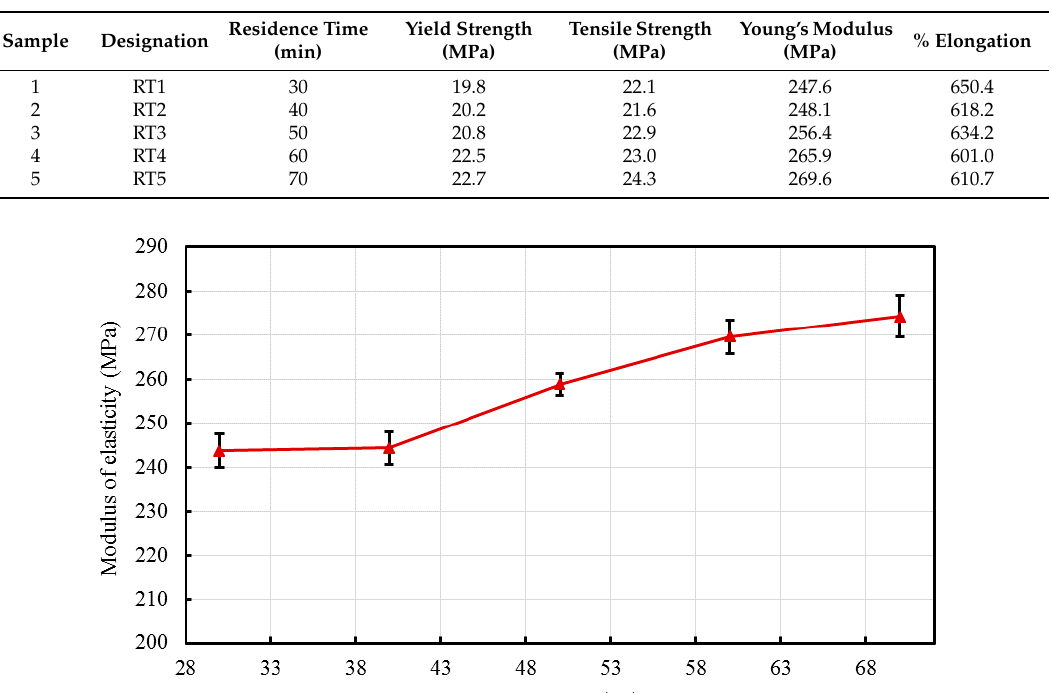
Figure 12. Effect of residence time on the modulus of elasticity of the developed HDPE-TiO 2 nanocomposites (SE bars included).